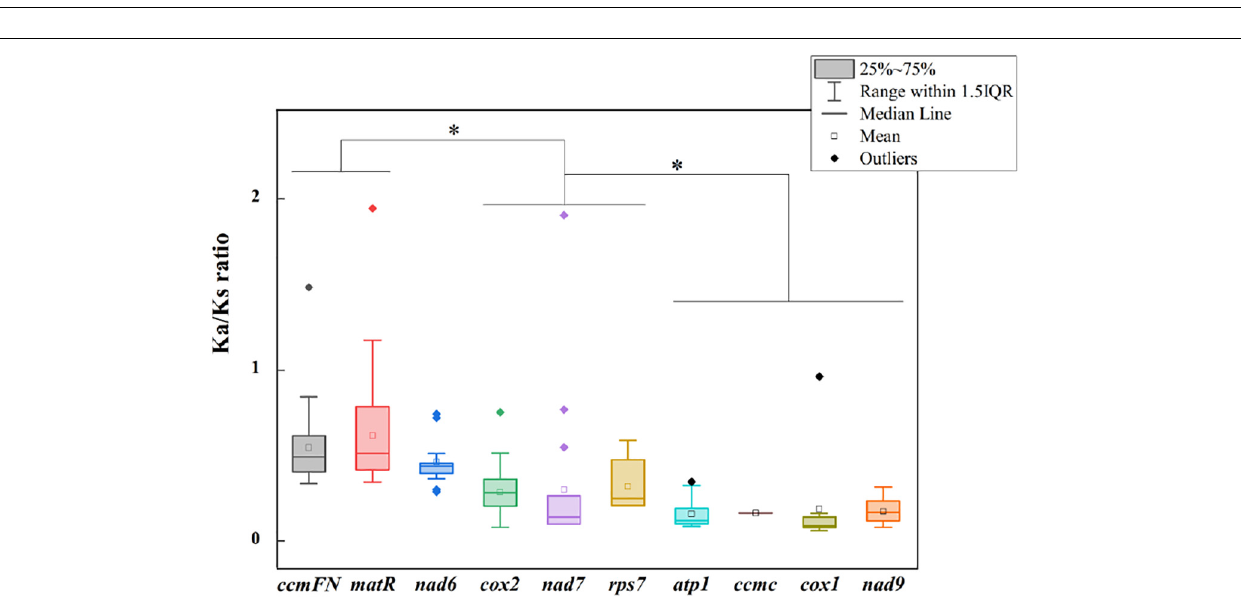
FIGURE 5 | Ka/Ks ratio calculated based on 10 shared genes among the nine Gramineae mitogenomes. ∗ indicates P < 0.01.